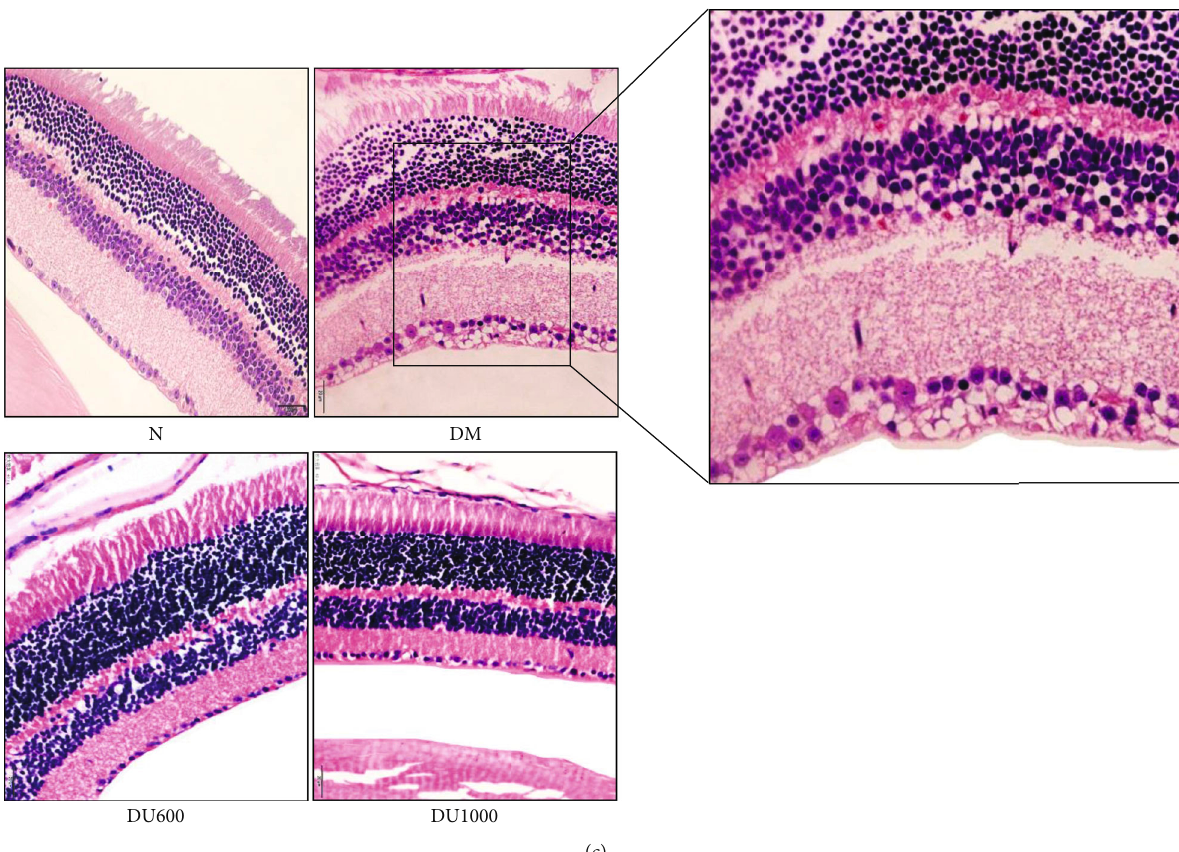
Figure 2: Overall retinal thickness and thickness of each layer and morphological changes. (a) Overall retinal thickness and thickness of each layer (40x). (b) Histogram comparison of overall retinal thickness and thickness of each layer. (c) Morphological changes of the retina (40x). Annotation: compared with the normal group, ∗ p < 0 : 05 , ∗∗ p < 0 : 01 , and ∗∗∗ p < 0 : 001 ; compared with the DM group, # p < 0 : 05 , ## p < 0 : 01 , and ### p < 0 : 001